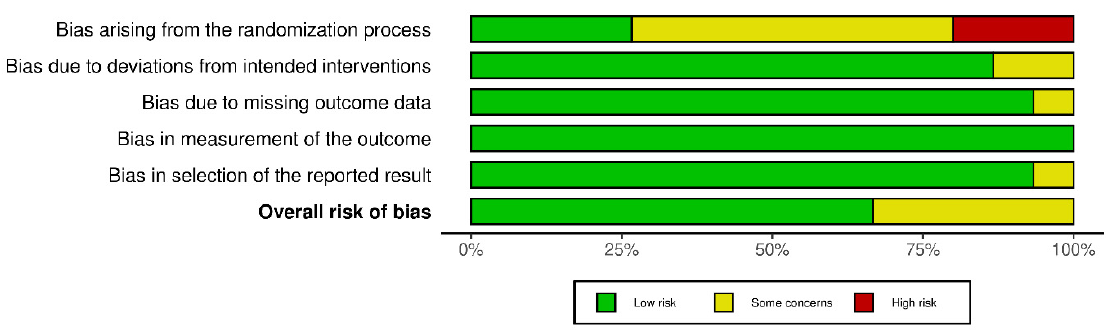
Figure 2. Domains of Risk of Bias (Randomized Controlled Parallel Studies) [39–53].